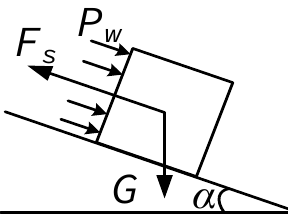
Figure 10. Stress diagram for the rock plug.